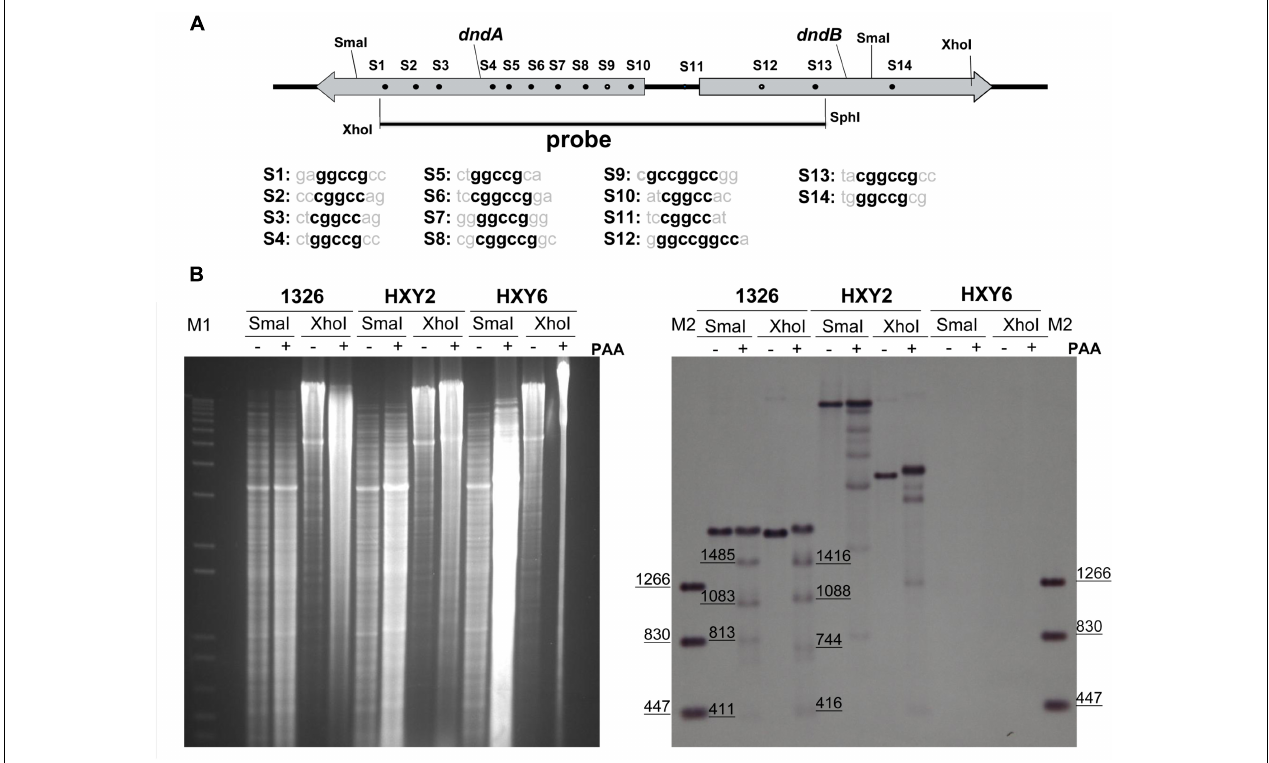
FIGURE 1 | Characterization of DNA sulfur-modified sites near dndB promoter region. (A) Potential DNA sulfur-modified sites near dndB promoter region. Sequences of 14 putative DNA sulfur-modified sites are aligned, and the consensus contexts are in bold. (B) To characterize DNA sulfur-modified sites near dndB promoter region, Genomic DNA from 1326, HXY2, and HXY6, was digested by Sma I or Xho I, then treated with PAA, separated on 0.7% agarose gel, and finally characterized using Southern blotting. “ − ” indicates without PAA; “+” indicates with PAA added. DNA markers for agarose gel electrophoresis are labeled as “M1”; DNA markers for Southern blotting are labeled as